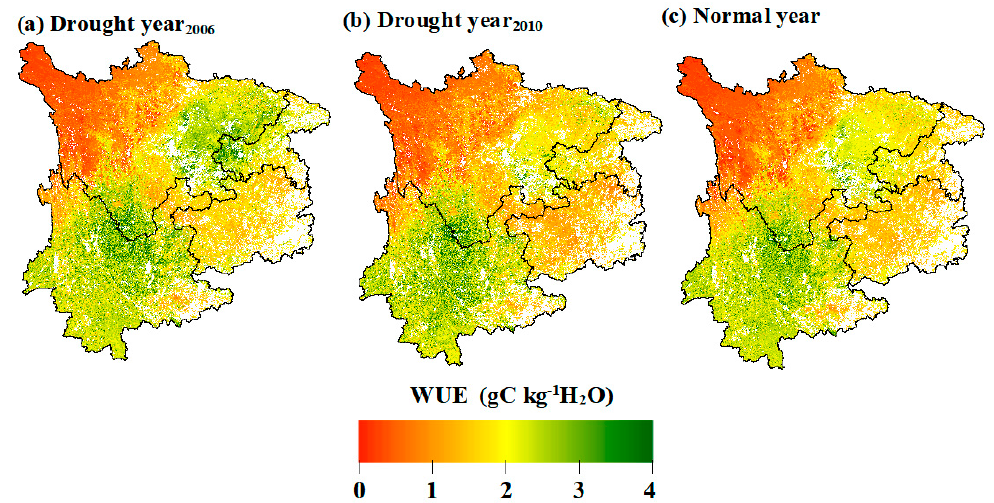
Figure 7. Spatial distribution of annual WUE in ( a ) 2006 (drought year), ( b ) 2010 (drought year), and ( c ) the normal year.